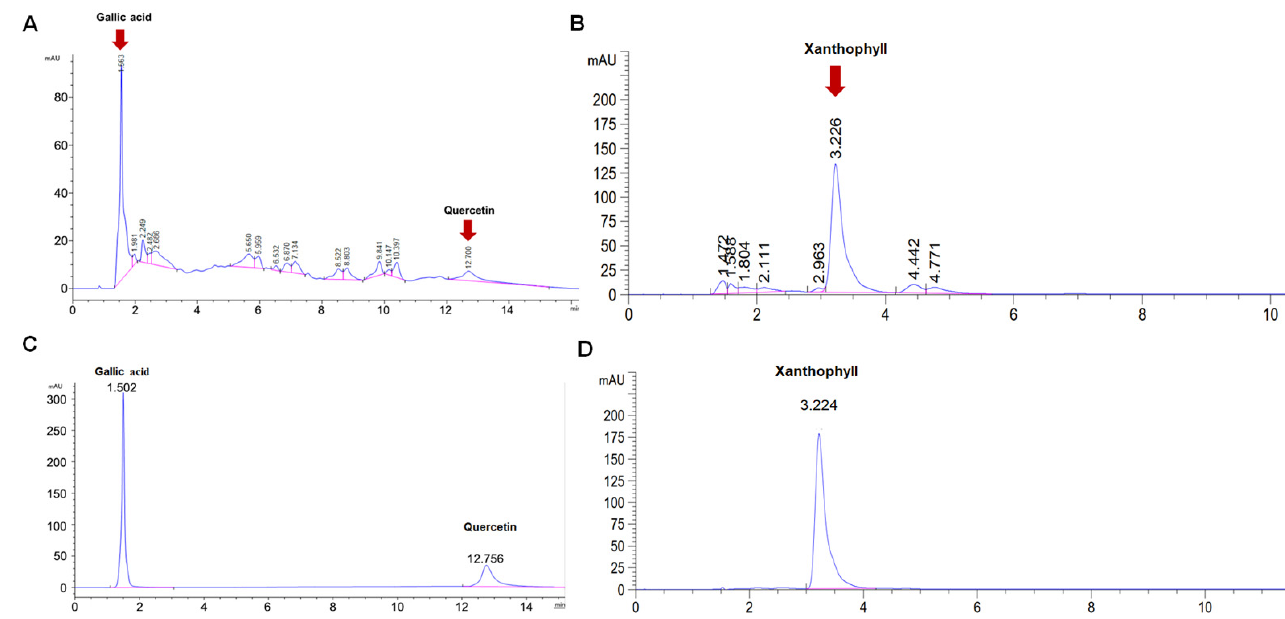
Figure 6. HPLC profile of non-sericin extract ( A , B ) compared to the standard gallic acid ( C ), quercetin ( C ), and xanthophyll ( D ) for analysis of bioactive compounds in non-sericin extract.